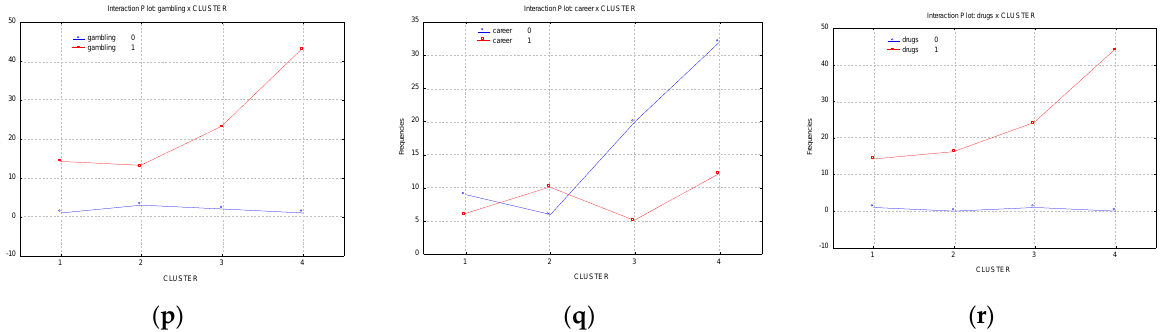
Figure 6. Distribution of borrowers over clusters by levels of categorized variables: gender ( a ), edu ( b ), empl ( c ), mar ( d ), avinc ( e ), bad_hab ( f ), ints ( g ), bad_env ( h ), mus ( i ), mov ( j ), inc ( k ), ideal_fam ( l ), profile ( m ), fraud ( n ), and illness ( o ). Distribution of borrowers over clusters by levels of categorized variables: gambling ( p ), career ( q ), and drugs ( r ).